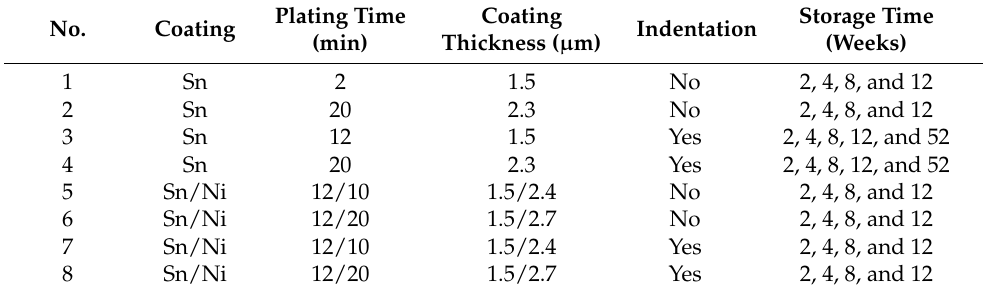
Table 3. List of